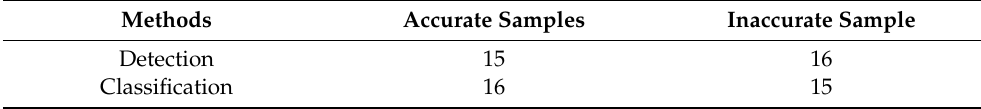
Table 3. The results of fracture detection and classification of 31 occult